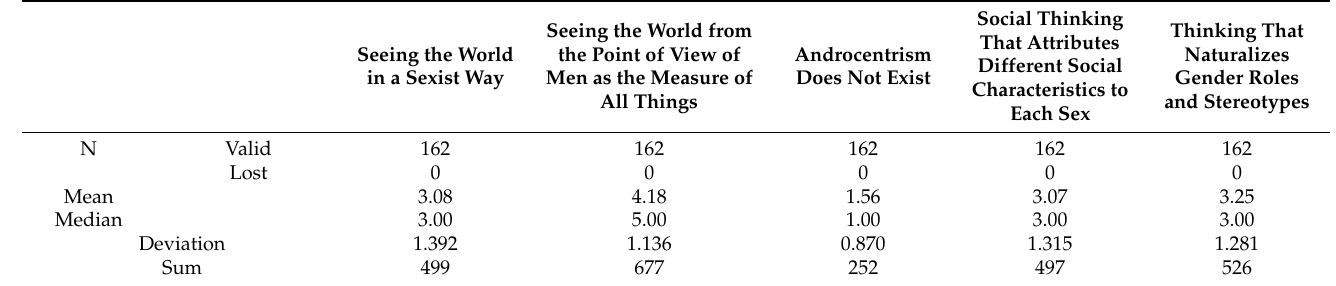
Table 5. Descriptive statistics of central tendency for question 3.